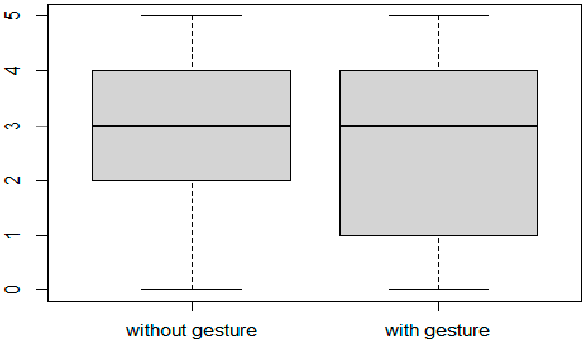
Figure 3. Box plot for testing results in Receptive Post-Test 1 condition.